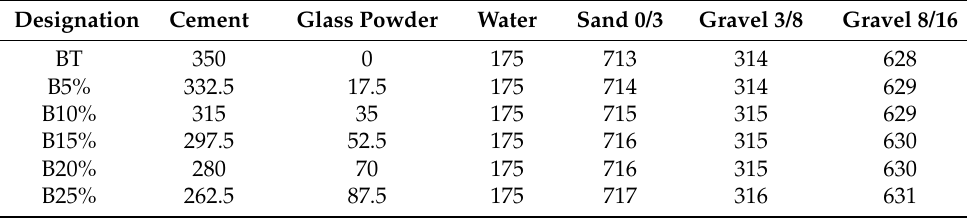
Table 4. Mix designs of one cubic meter of concrete in kg/m 3